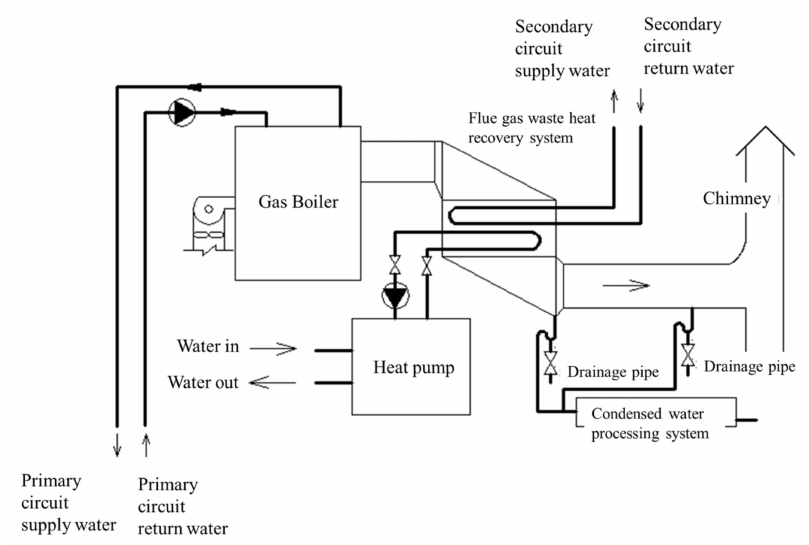
Figure 3. System diagram of case 3